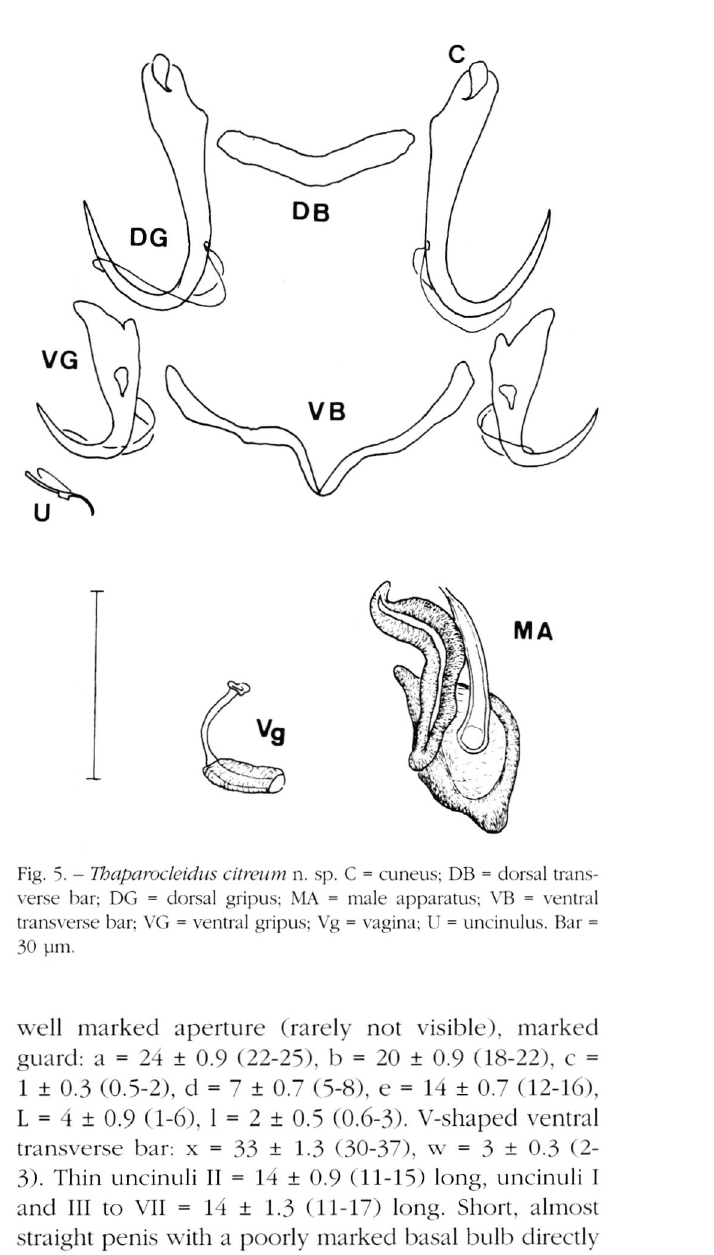
Fig. 5. - Thaparocleidus citreum n. sp. C = cuneus; DB = dorsal trans verse bar; DG = dorsal gripus; MA = male apparatus; VB = ventral transverse bar: VG = ventral gripus; Vg = vagina; I' = uncinulus. Bar = 30